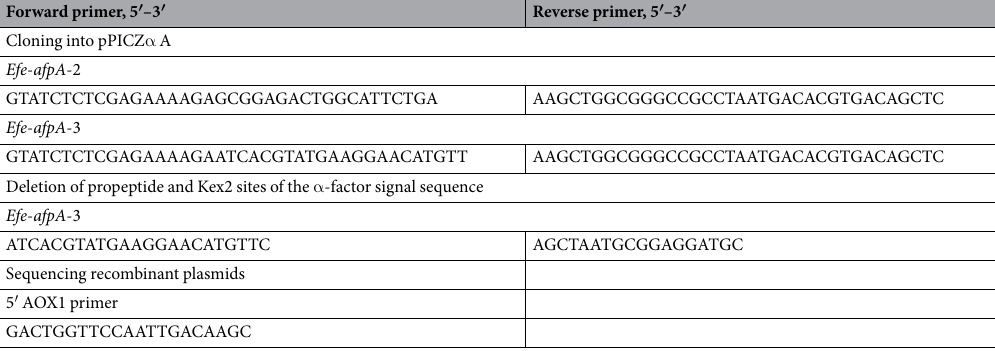
Table 1. Sequences of oligonucleotide primers used in this